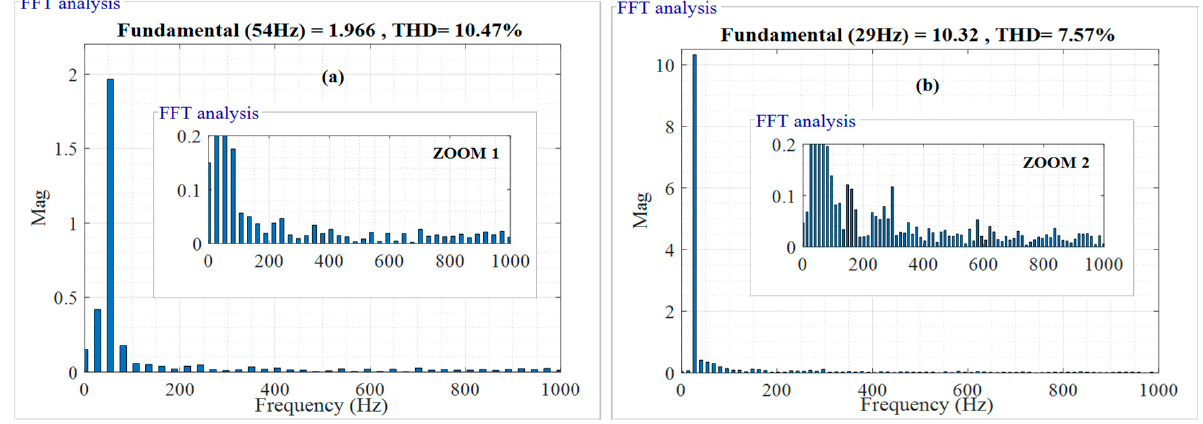
Figure 10. Stator ( a ) and rotor ( b ) current THD of the DTC .